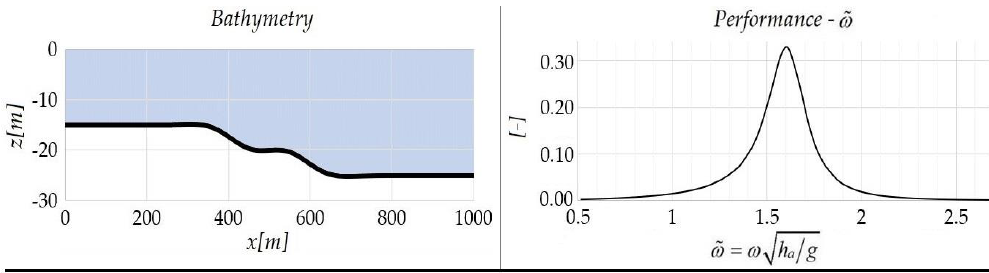
Figure 16. Considered OWC’s performance curve in variable bathymetry. ( Parameters : h a = 10 m , h b = 25 m , b = 2.5 m , d = 0.5 m , D = 5 m , (cid:101) λ = − 2.1, h c = 5 m , κ = 0.015, δ h c ( x ) = 4sin [ 0.02